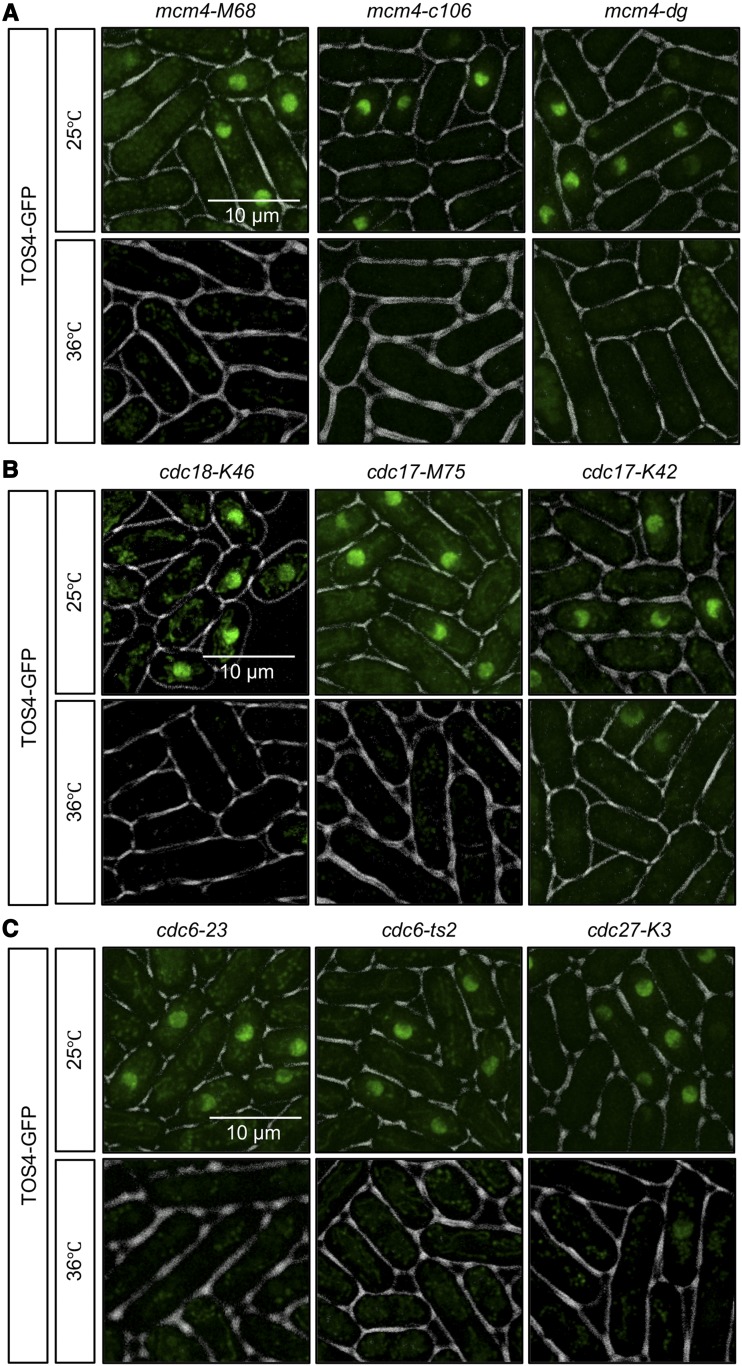
Replication mutants lack nuclear Tos4-GFP. Temperature-sensitive Mcm4 helicase mutants (mcm4-M68, mcm4-c106, mcm4-dg) (A), MCM loader mutant (cdc18-K46), ligase mutants (cdc17-M45 and cdc17-K42) (B), and polymerase delta mutants (cdc6-23, cdc6-ts2, and cdc27-K3) (C) were imaged for Tos4-GFP in asynchronous culture at 25°C or after 4 h at 36°C.